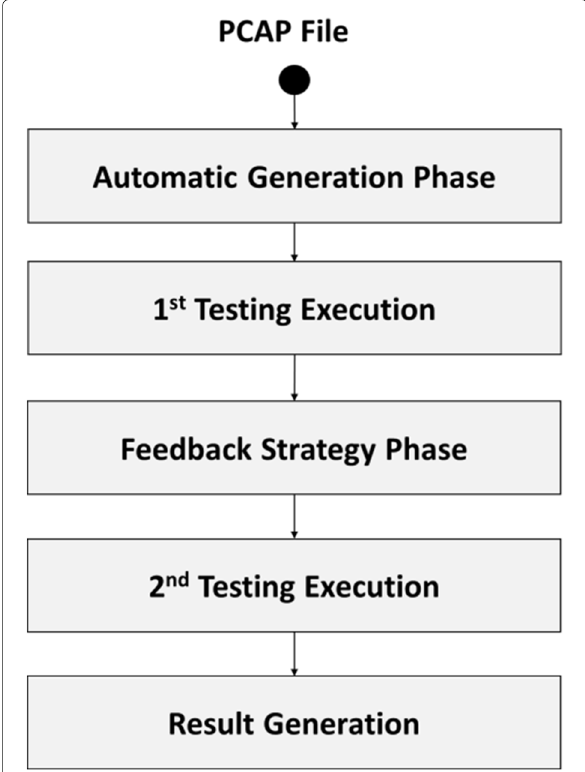
Fig. 1 The two phases of ICPFuzzer. The automatic generating phase and the feedback strategy phase